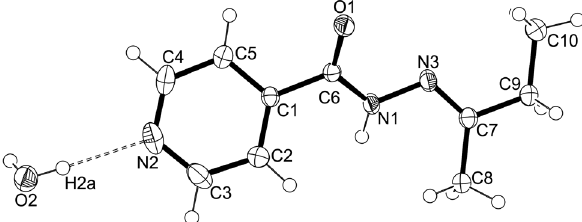
Table  : Data collection and